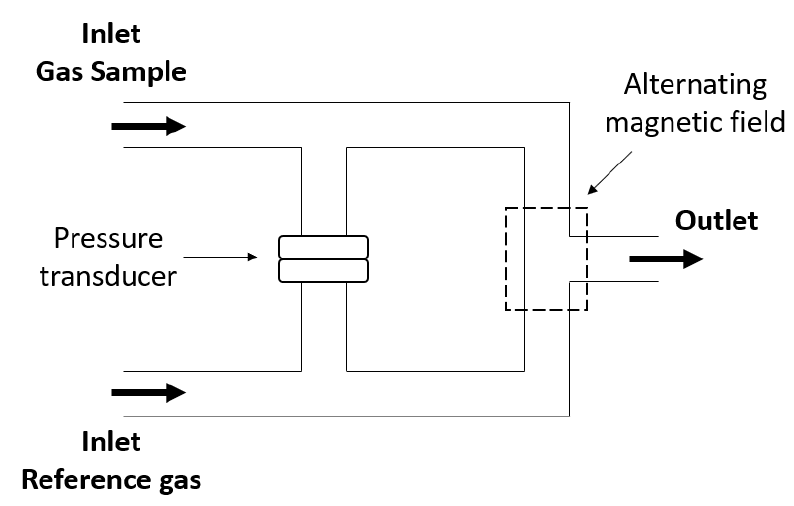
Figure 6. Schematic drawing of a paramagnetic oxygen sensor consisting of two gas inlets, sample and reference, a pressure transducer and an electromagnet to generate an alternating magnetic field with the bold arrows indicating the direction of gas flow.